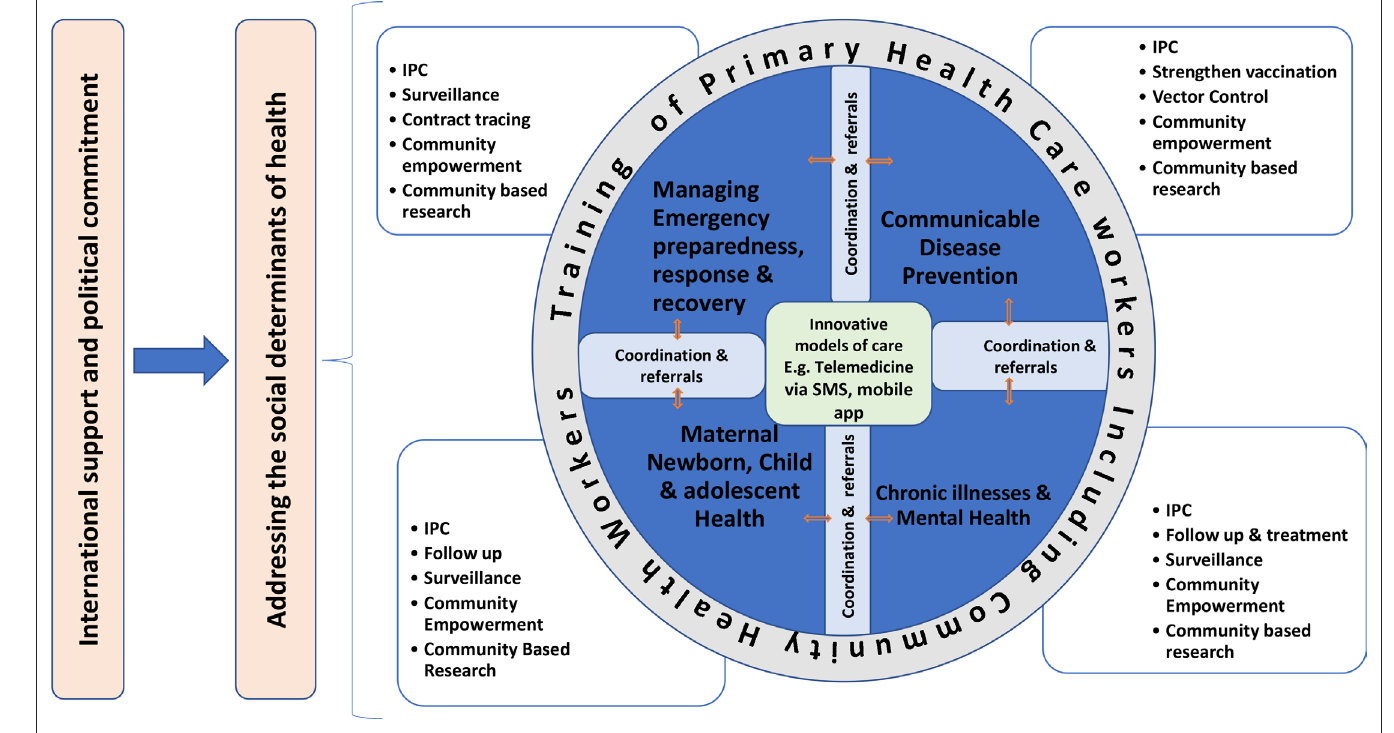
Figure 1 Primary Health Care Framework in the ‘new normal’ within the context of